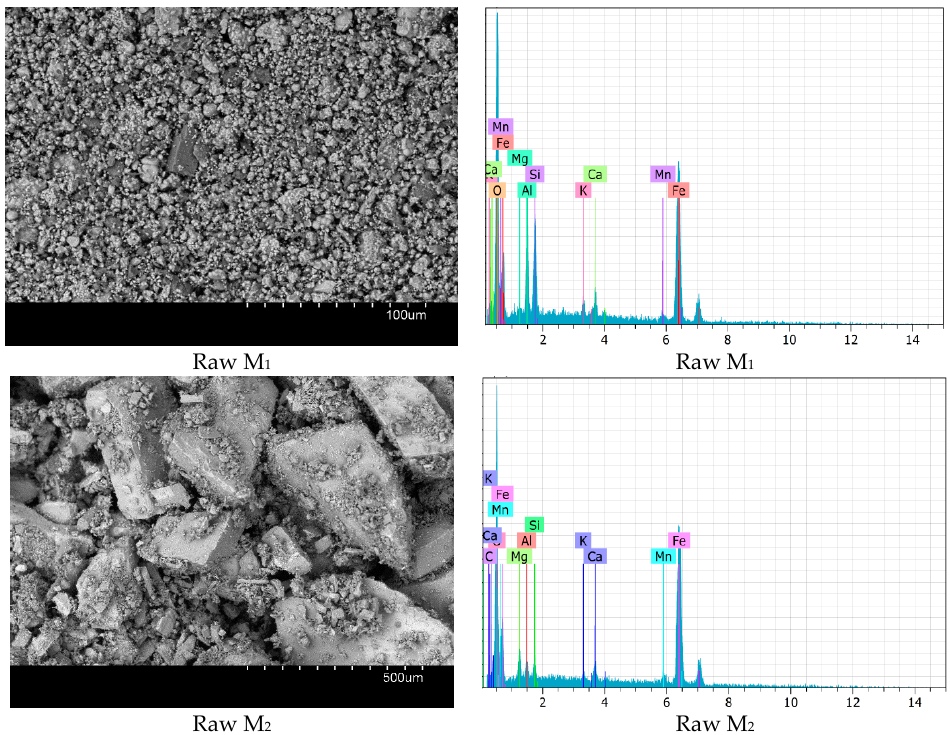
Figure 6. SEM images and EDX spectra for the raw materials M 1 and M 2 .